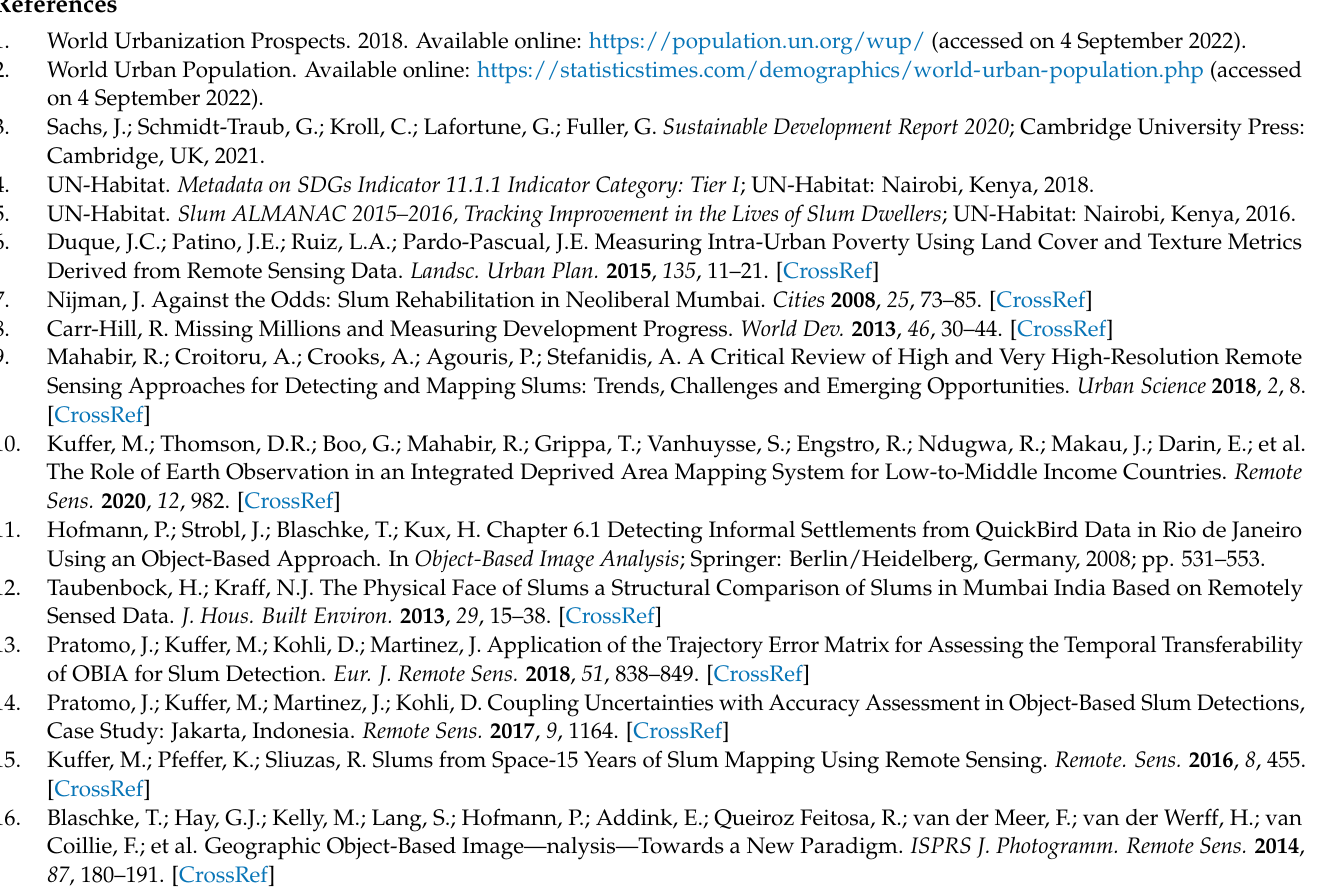
Figure A2. Comparison of the outcome generated by Modified FCN-DK6_2 and FCN-DK6 for tile-3. (Location highlighted by red circle represents those places where Modified FCN-DK6_2 performs better than FCN-DK6 because of the availability of GSV